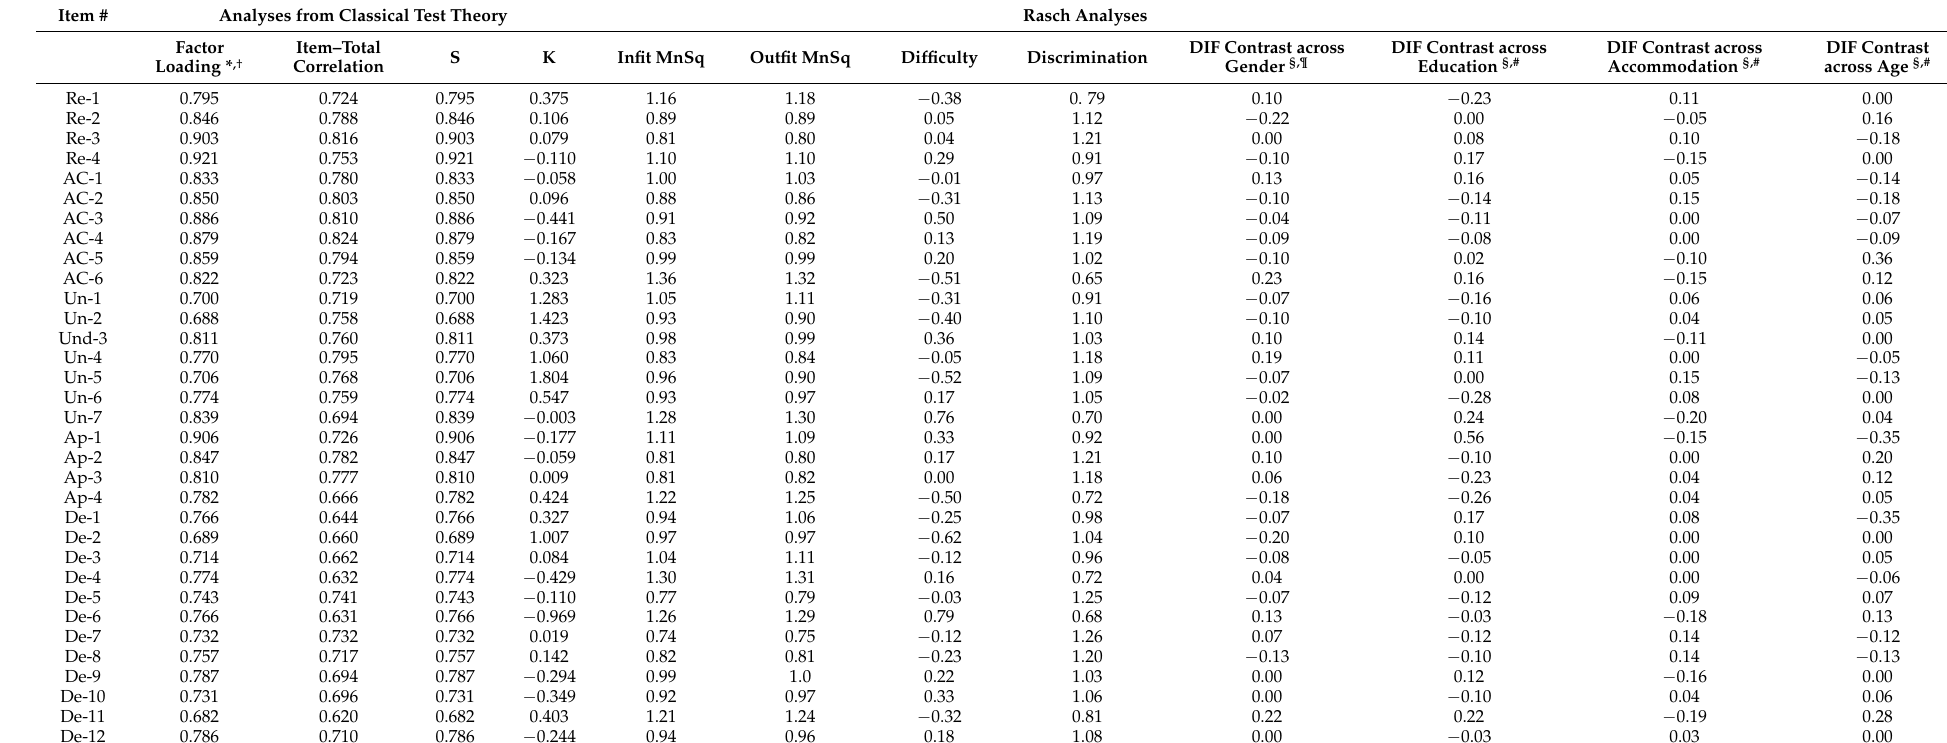
Table 2. Psychometric properties of the Health Literacy Instrument for Adults at the item